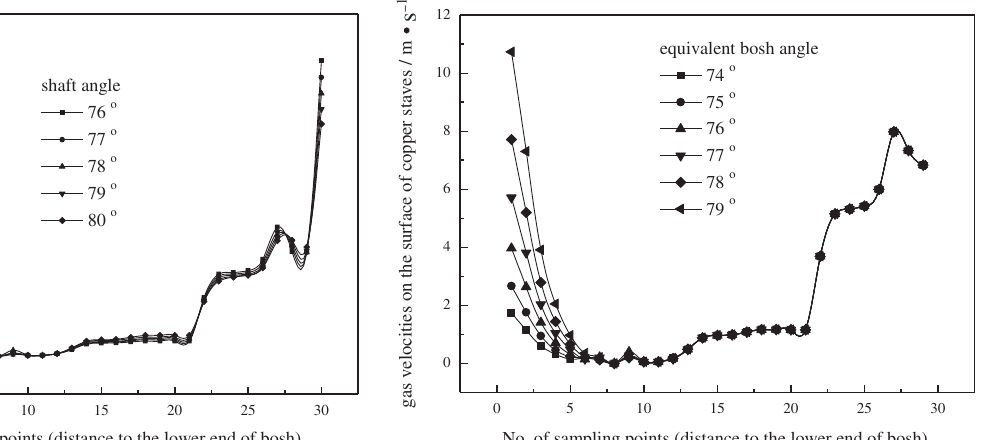
Figure 5: The velocities of the gas flow on the surface of the cooling stave under different conditions of variational shaft angles.